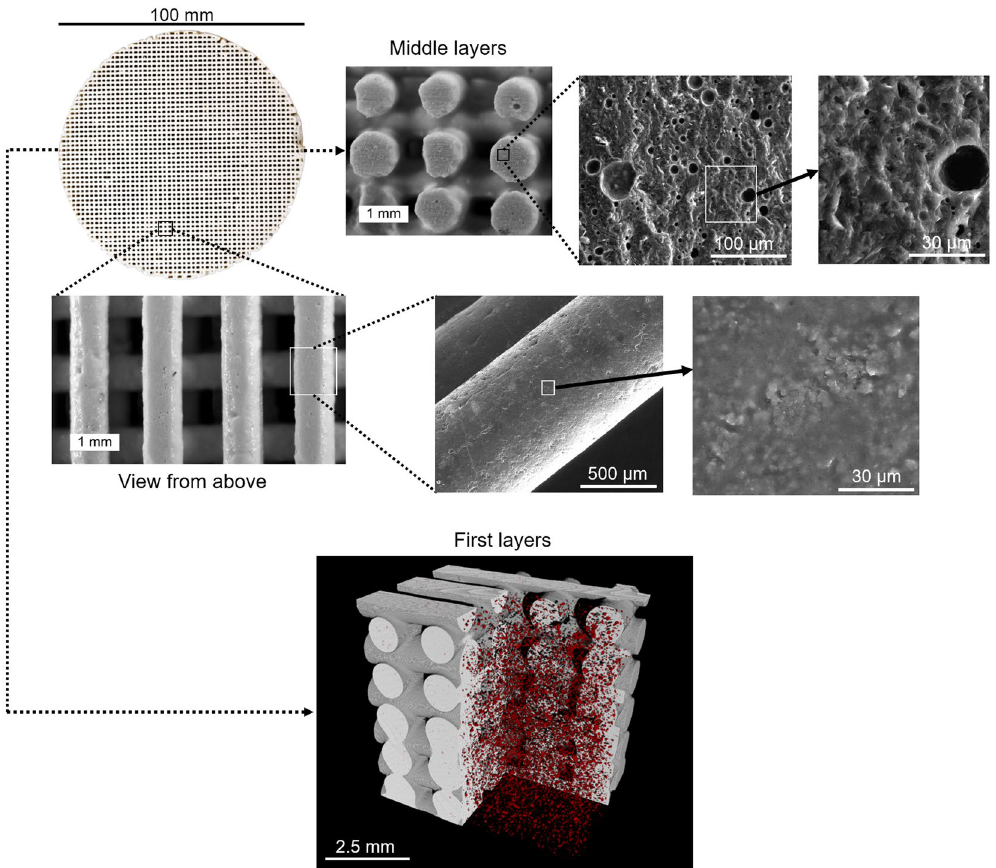
Figure 3. 3D-printed geopolymer filter imaged with a DSLR camera, optical microscopy, scanning electron microscopy (SEM), and X-ray microtomography. In the microtomography image, red dots represent the internal (closed) pores, which are also visible in the cross-sections imaged with